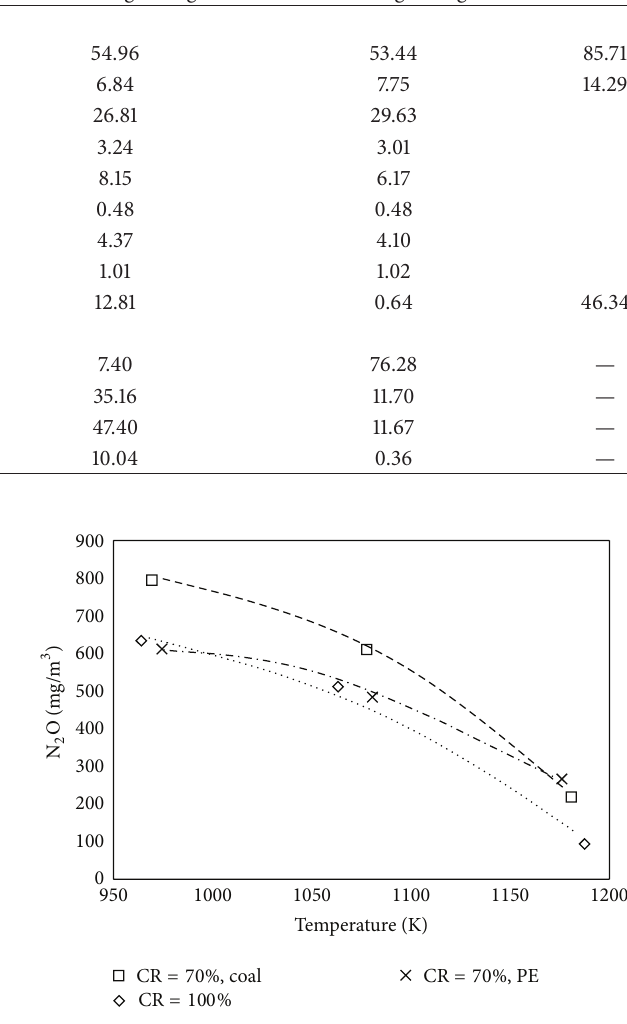
Table 3: Composition of the ash of coal and sewage sludge.